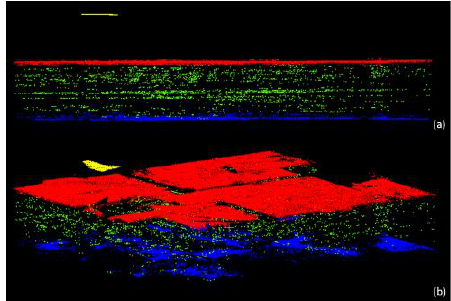
Figure 10. Plane selected for first level; (a) longitudinal section; (b) axonometric view.